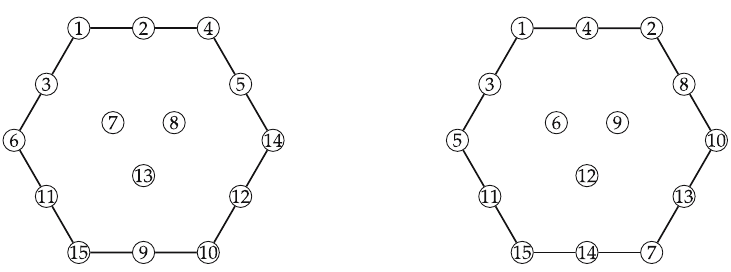
Figure 5: Two isomorphic triangular matroids induced by A 15 ( left ) and B 15 ( right )